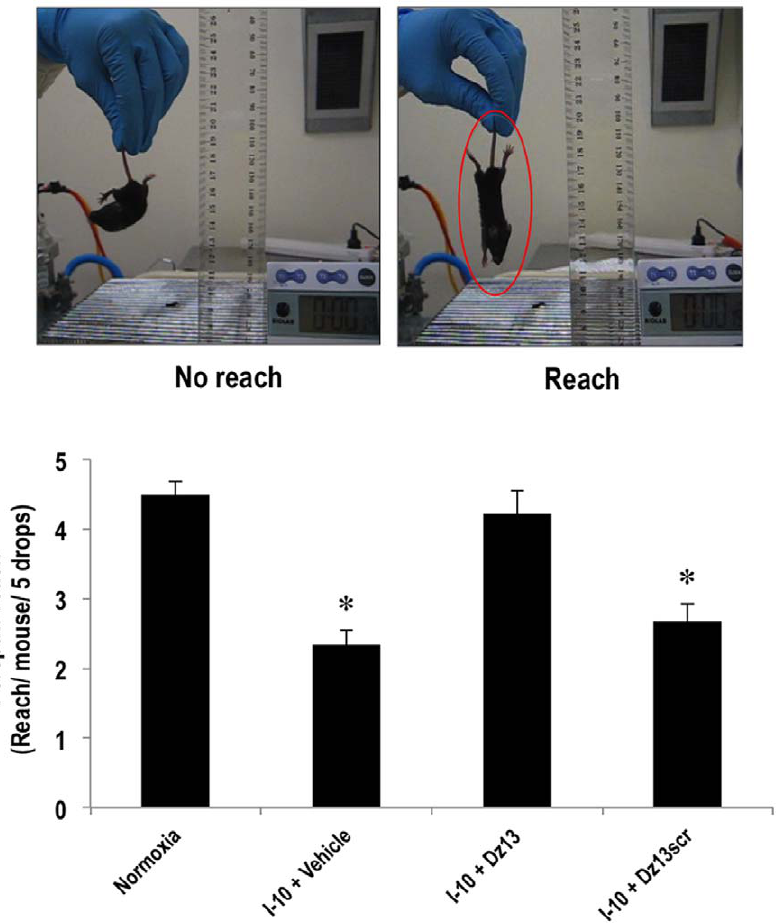
Figure 5. Effect of Dz13 treatment in a modified forepaw reach model. C57BL/6 mice (I-0) were injected with Dz13 or Dz13scr (20 m g) in H 2 O containing DOTAP/DOPE and on I-10, the animals were subjected to the forepaw reach reflex test. Mice forepaw-reaching reflex at the cage top was determined 5 times for each mouse. The observer was blinded to the groups. The circled mouse displays forepaw reach. n=6–8 eyes per group. Data is representative of 2 or more experiments. * denotes P , 0.05 relative to vehicle or